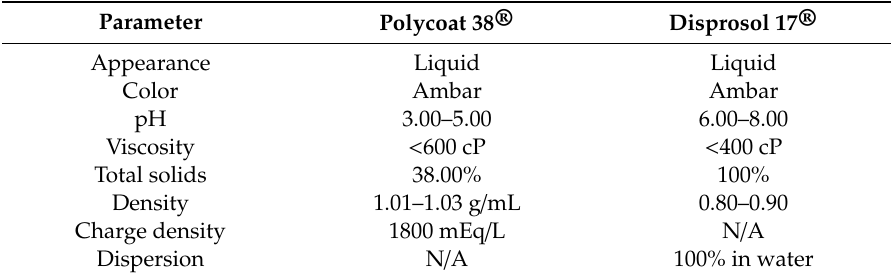
Table 2. Quality parameters of the Coating (Polycoat 38) and the release agent (Disprosol